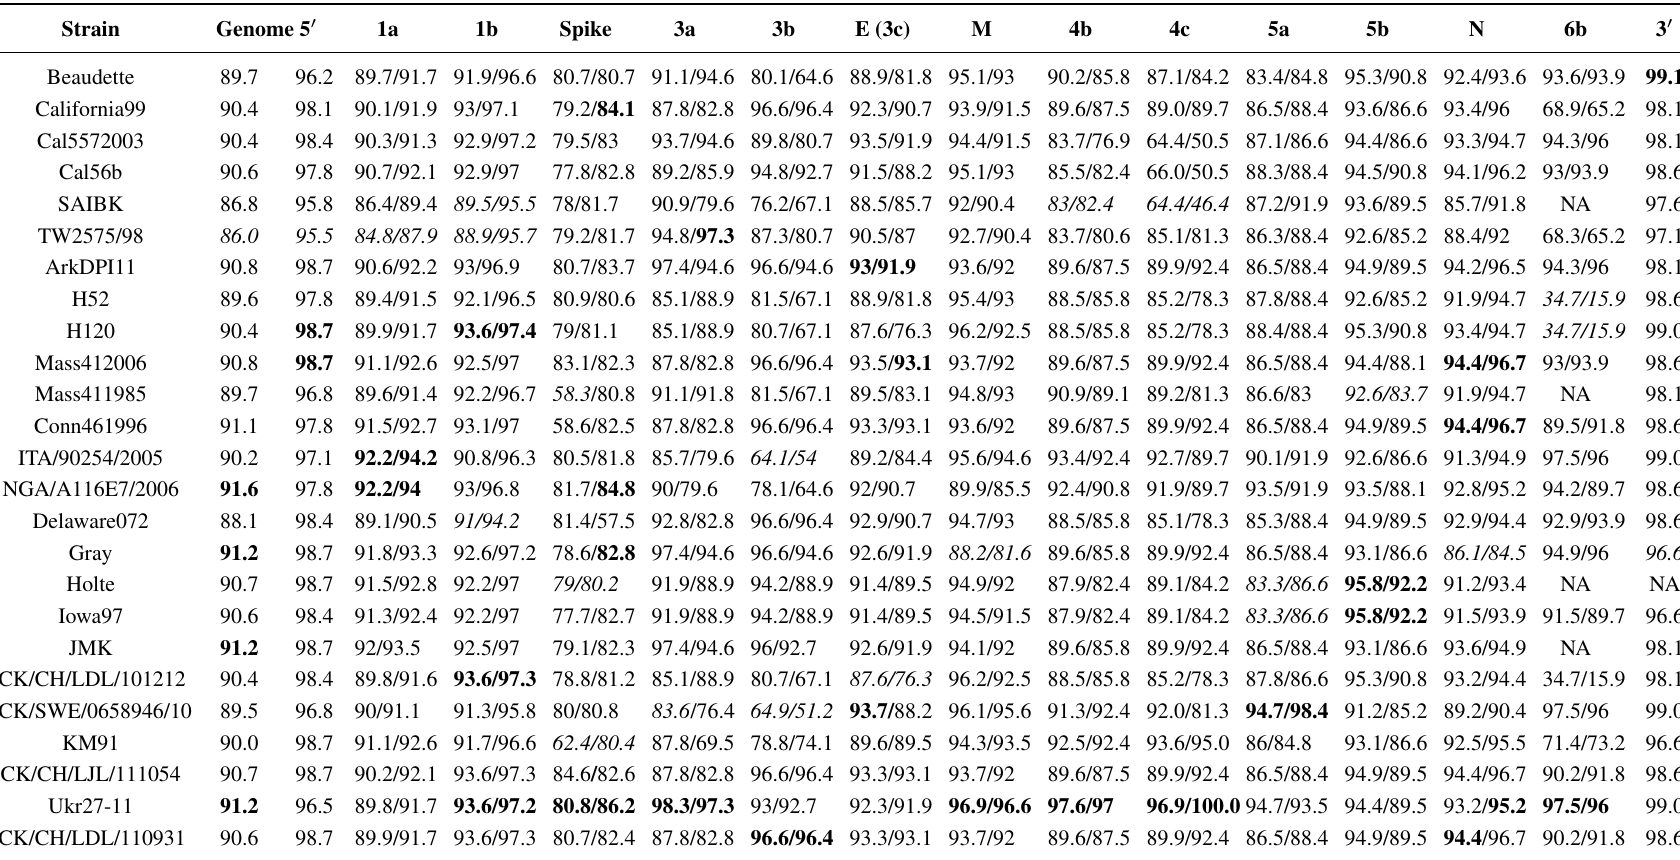
Table 2. Nucleotide and amino acid sequence identity (%) of B1648 genome with relevant genomes of Infectious Bronchitis Virus (IBV).